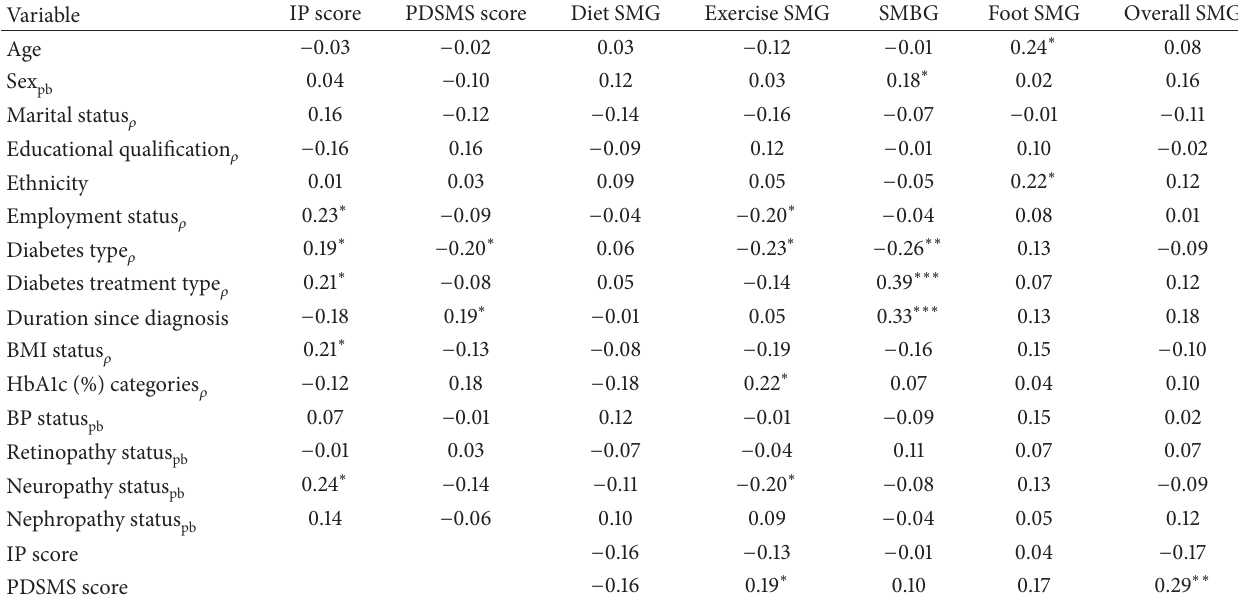
Table 1: Bivariate relationships between sociodemographic and disease characteristic variables and psychosocial dependent